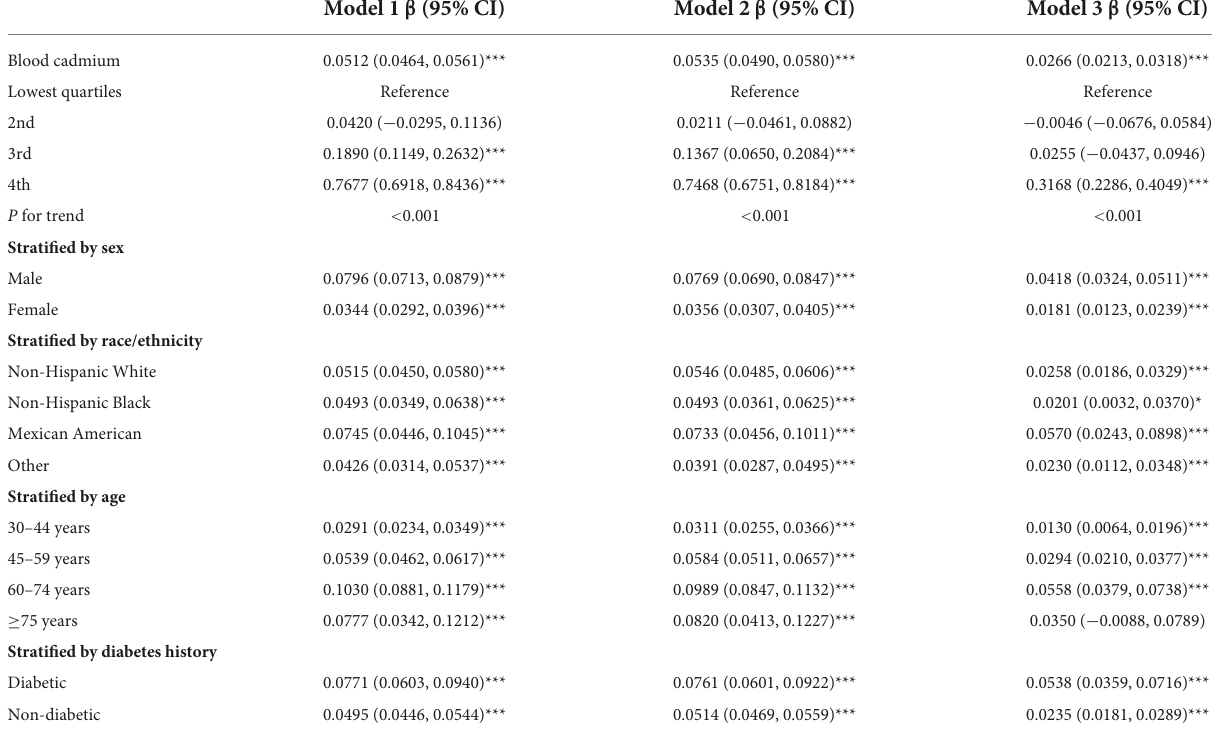
TABLE 5 Association between blood cadmium concentration ( µ mol/L) and CAL (mm), and stratified by sex, race/ethnicity, age, and diabetes history.